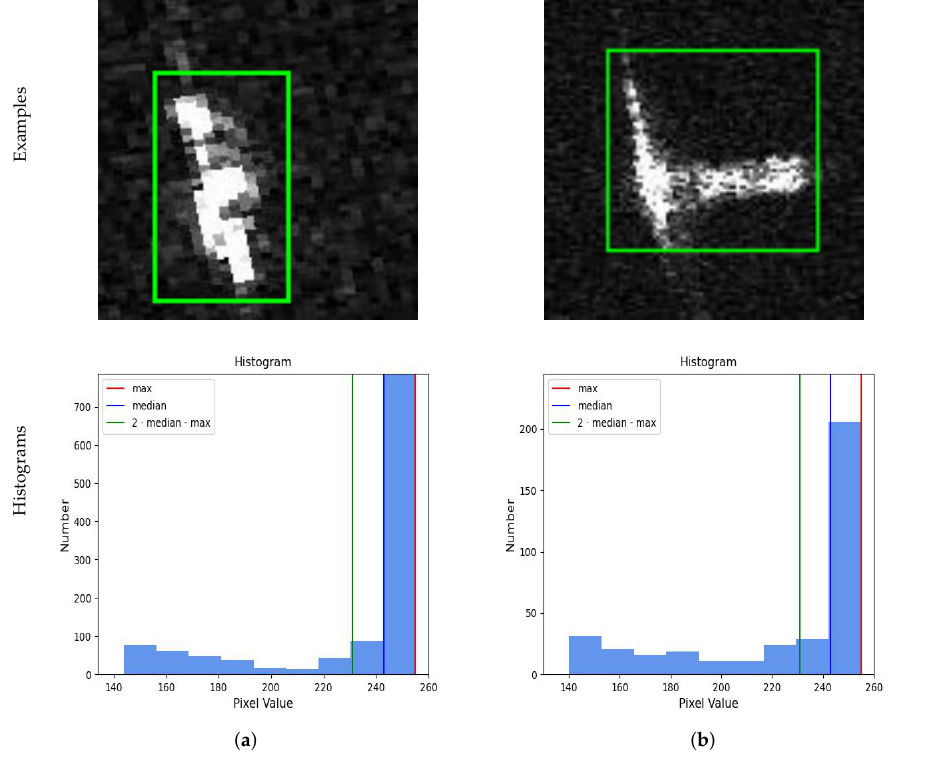
Figure 4. Two ship examples and their histograms. In the example, only the pixels in the green box (on the images from first row) are included in the distribution for the second row. ( a ) Ship pixel distribution example 1. ( b ) Ship pixel distribution example